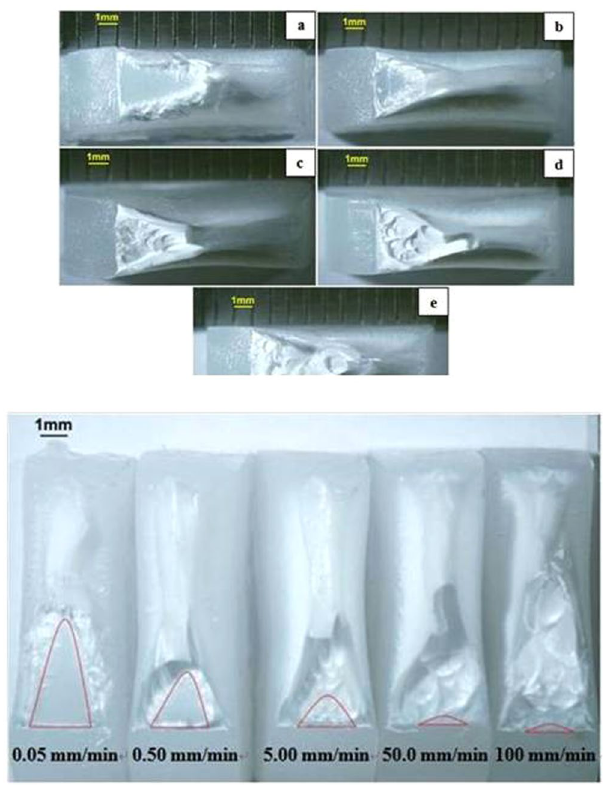
Figure 8. ( a ) Optical microscopy images of blunt notched specimens at various crosshead speeds (notch at the left, crack propagating from left to right). ( a ) 0.05 mm/min; ( b ) 0.50 mm/min; ( c ) 5.00 mm/min; ( d ) 50.0 mm/ min; ( e ) 100 mm/min at 25 °C. ( b ) Critical crack length of blunt notched specimens seen in optical microscopy (notch at the bottom, crack propagating from bottom to top) ( a) 0.05 mm/min; ( b ) 0.50 mm/min; ( c ) 5.00 mm/ min; ( d ) 50.0 mm/min; ( e ) 100 mm/min at 25 °C.